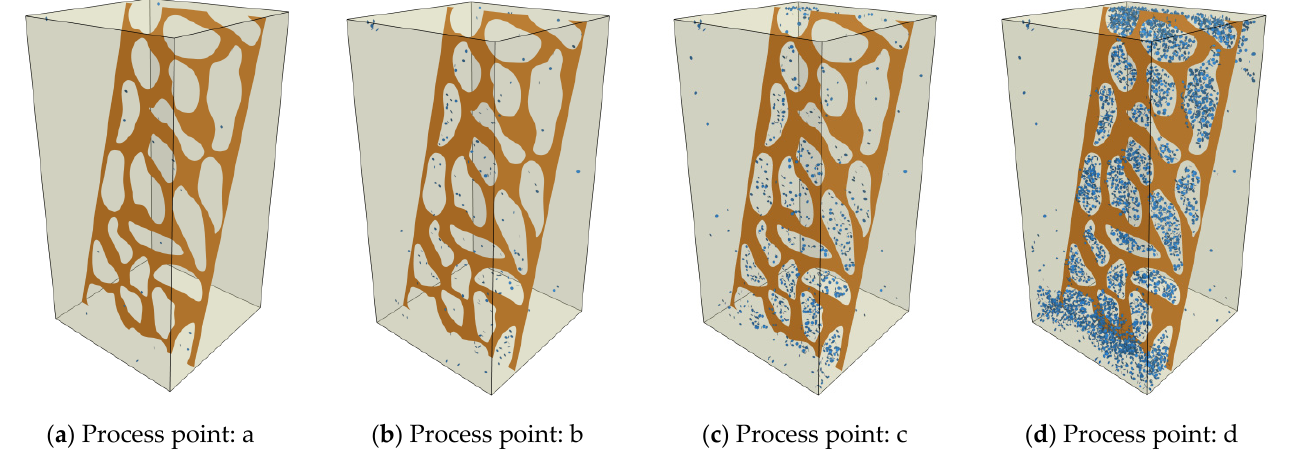
Figure 12. Microcrack development in specimen S − 75 − K1.